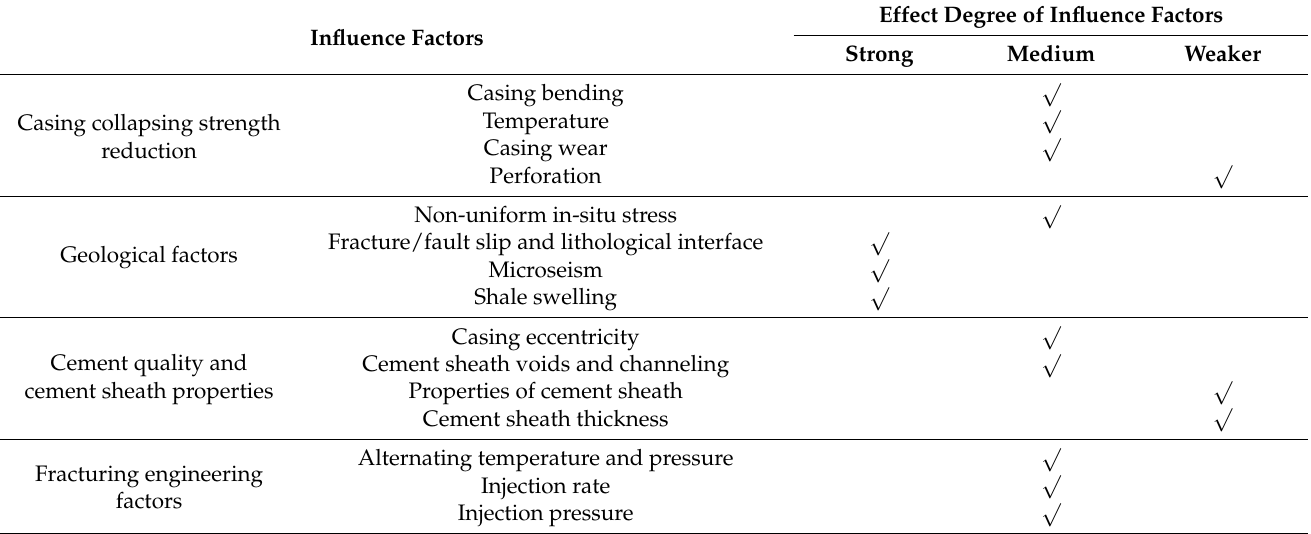
Table 2. Effect degree of influence